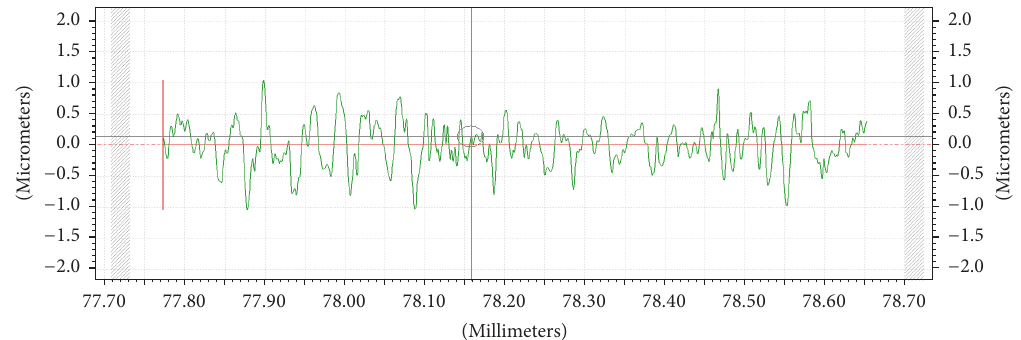
Figure 12: 2D roughness profile of Inconel 718 (parameters: temperature: 50 ∘ C, concentration: 600 g/L, and time: 40 minutes).